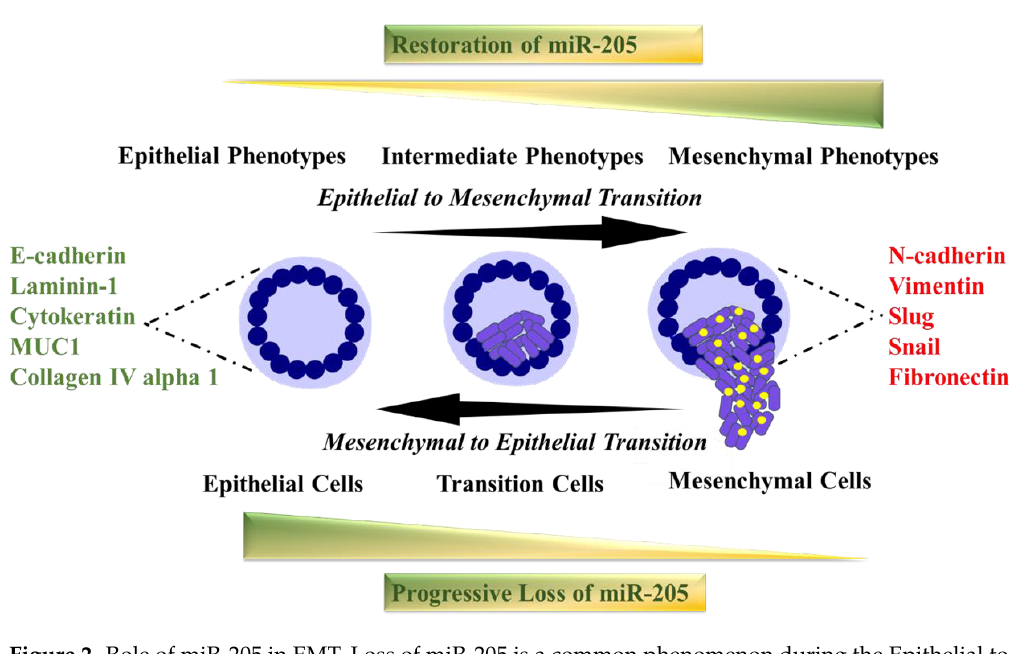
Figure 2. Role of miR-205 in EMT. Loss of miR-205 is a common phenomenon during the Epithelial to Mesenchymal Transition (EMT). Reversal of EMT is possible once miR-205 is restored in these cells via supplementing it through nanotechnology.